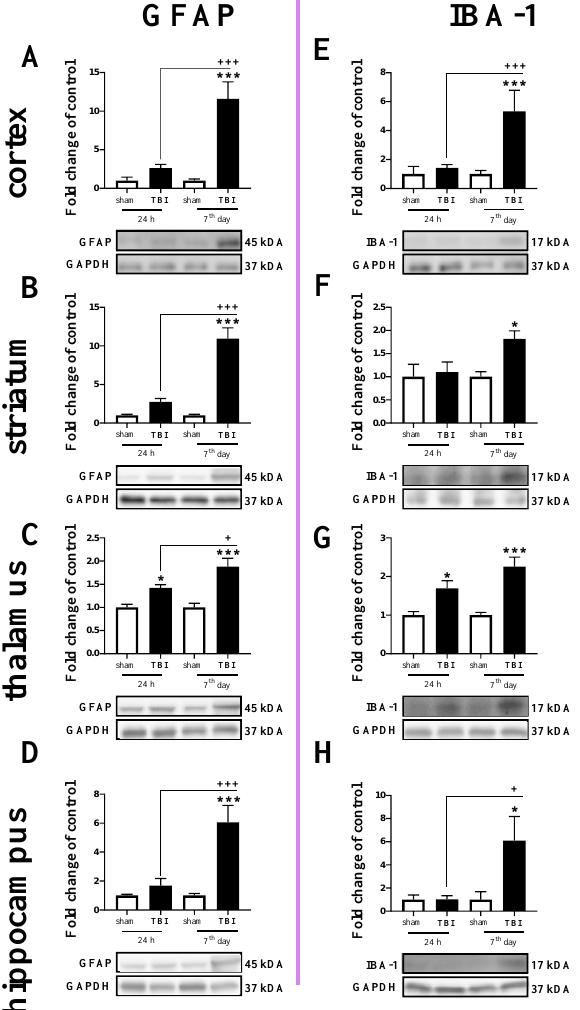
Figure 3. A – H. The protein expression changes of IBA-1 and GFAP in the cortex, striatum, thalamus, and hippocampus of TBI compared to sham-injured animals at different time points (24 h and 7th days). The data are given as fold changes relative to the control as mean ± SEM (sham groups, n = 4–6; TBI groups, n = 4–6). * p < 0.05; *** p < 0.001 show differences considered statistically significant between the sham and TBI groups, + p < 0.05; +++ p < 0.001 show differences considered statistically significant comparing to the 24 h TBI group as estimated by two-way ANOVA followed by Bonferroni’s post hoc test.